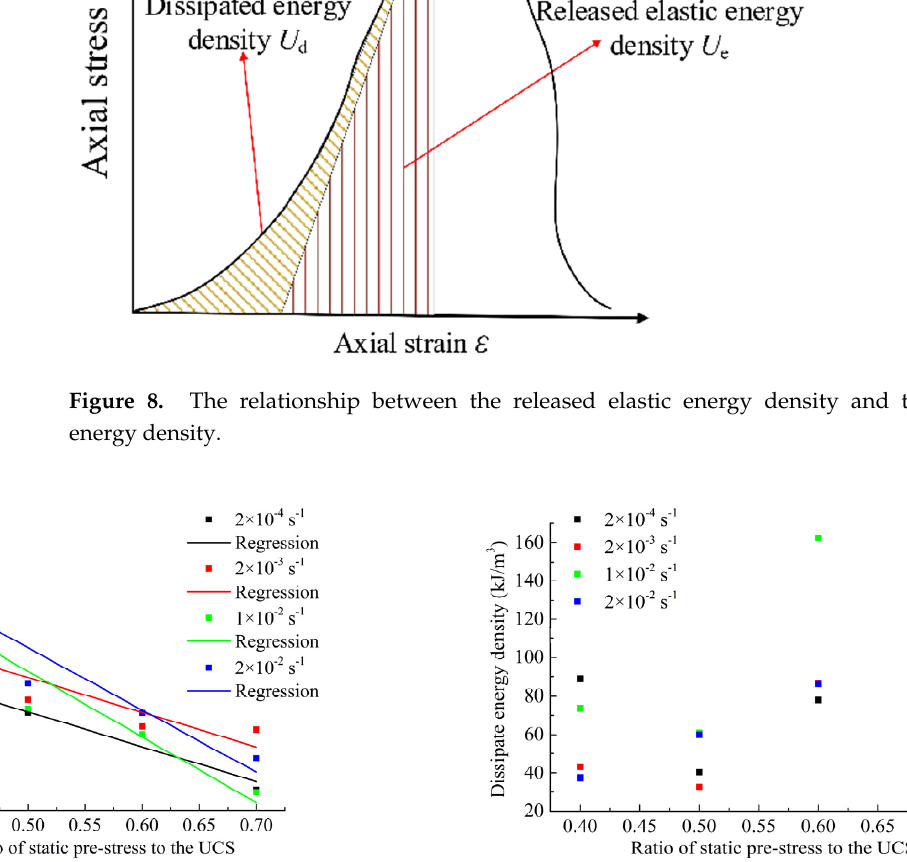
released elastic energy increases logarithmically. When the static pre-stress is greater than